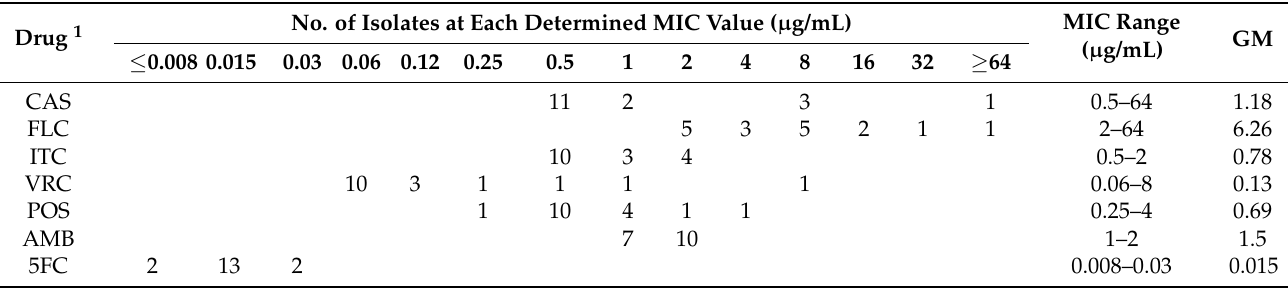
Table 2. Summary of antifungal susceptibility of 17 Candida glabrata isolates. Drug